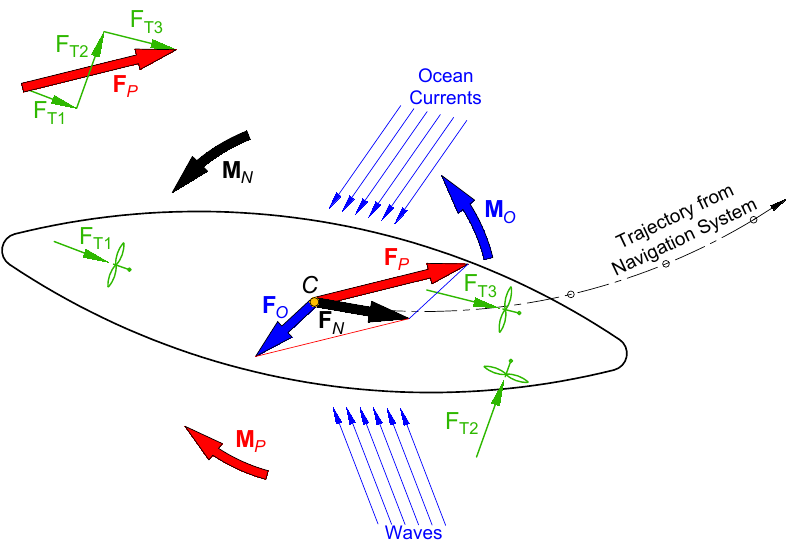
Figure 6. A 2D model for the vectorial thrust